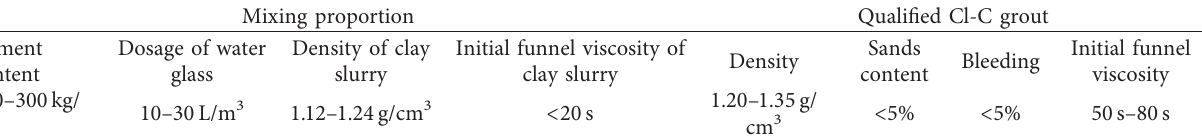
Table 2: Technical requirements of Cl-C grout and the clay slurry.